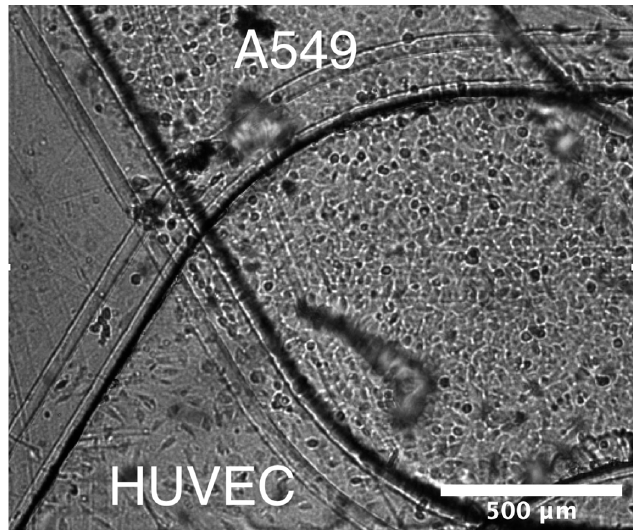
Figure 2. A brightfield image of the two microchannels converging with a monolayer grown in each channel (A549 top channel, HUVEC bottom channel) along the membrane